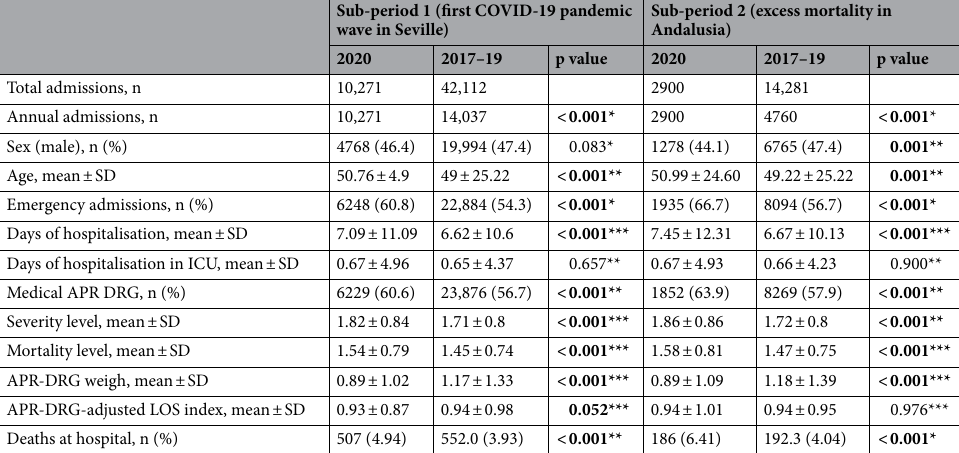
Table 1. Characteristics of non-COVID patients admitted to the Virgen del Rocío University Hospital between February 27 and June 7, 2020 (sub-period 1) and between March 17 and April 20, 2020 (sub-period 2), compared with the same sub-periods in 2017–19. SD standard deviation, ICU intensive care unit, APR-DRG all patient refined diagnosis related groups, LOS length of stay; *Chi-Square test; **Student T-test; ***Mann– Whitney U-test. Significant values are in bold.